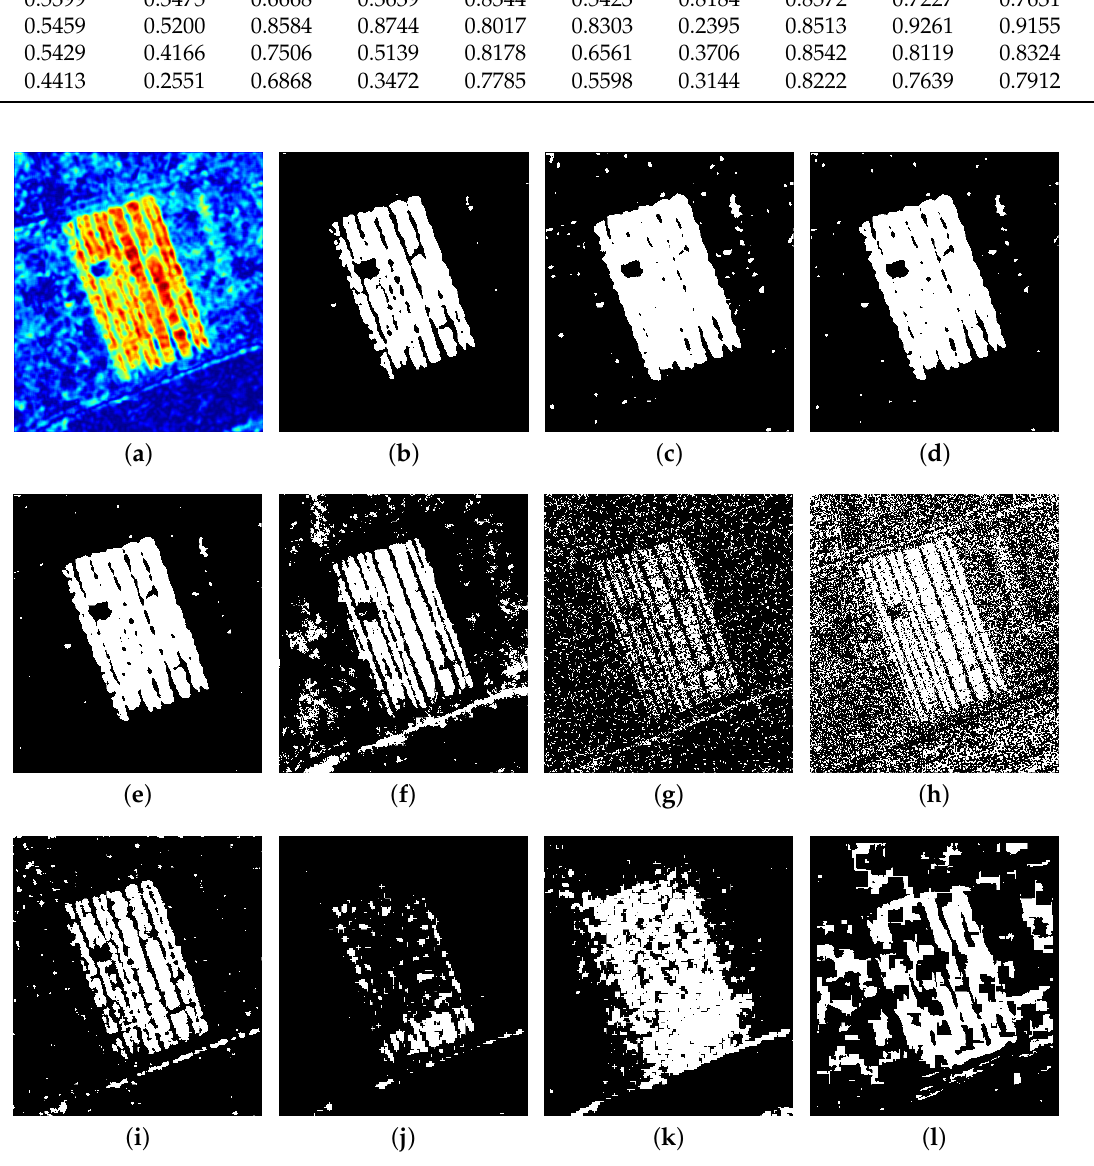
Figure 5. Change maps of the different methods on Dataset #1. ( a ) DI of proposed method